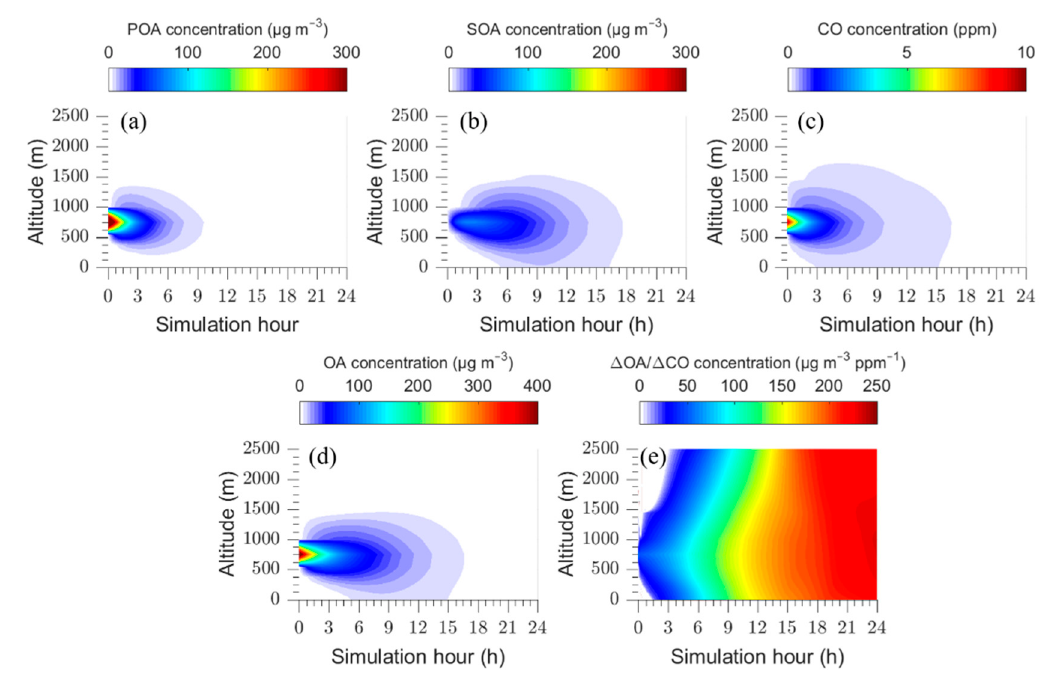
Figure 9. Time dependent vertical profiles of: ( a ) POA; ( b ) SOA; ( c ) CO; ( d ) total OA; and ( e ) ∆ OA/ ∆ CO assuming a horizontal dilution rate constant of k = 10 − 4 s − 1 .